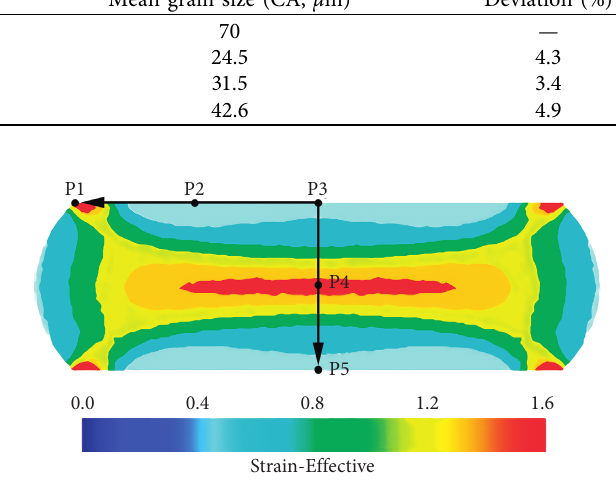
Figure 4: The coloured strain pattern of the cylinder sample with strain rate of 0.01 s − 1 at 350 ° C.